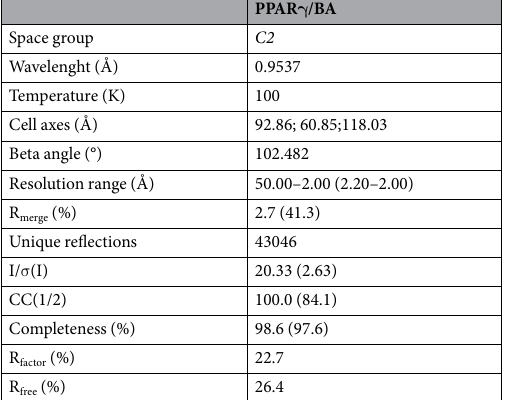
Table 1. Statistics of Crystallographic Data and Refinement. * The values in parentheses refer to the outer shell.